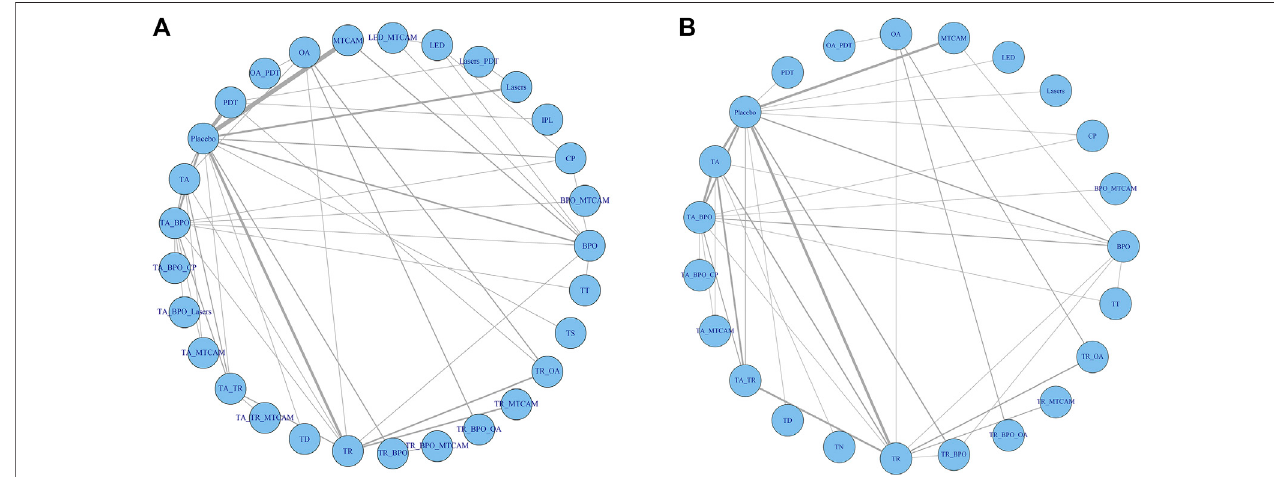
FIGURE 2 | Network analysis plots. (A) Nonin fl ammatory and in fl ammatory lesions count. (B) Risk of adverse effects.